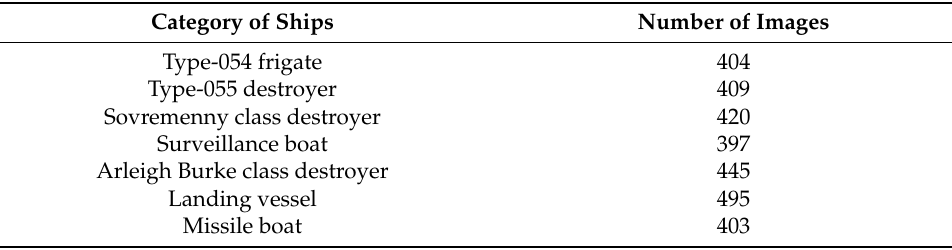
Figure 3. Some samples of the military ship dataset: ( a ) Type-054 frigate, ( b ) Sovremenny class destroyer, ( c ) Type-055 destroyer, ( d ) Surveillance boat, ( e ) Arleigh Burke class destroyer, ( f ) landing vessel, and ( g ) missile boat. Table 1. Number of categories in military ship